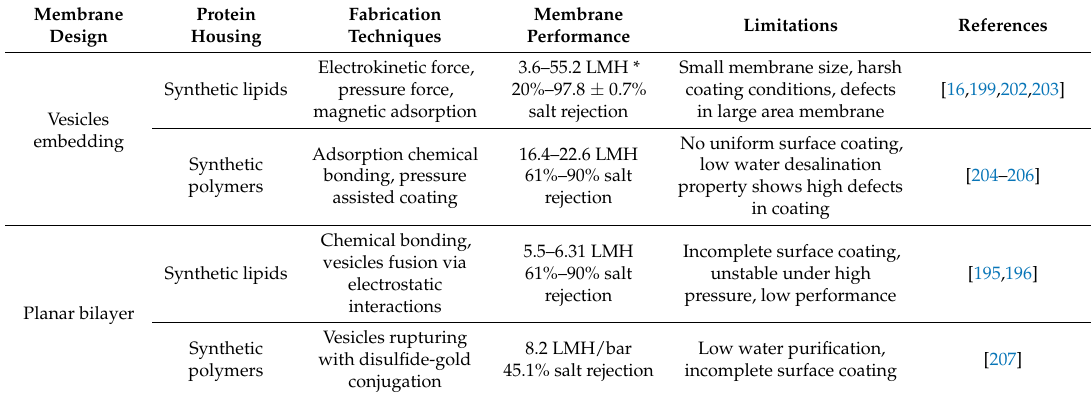
Table 4. Summarizes the performance of aquaporin biomimetic membranes based on their two